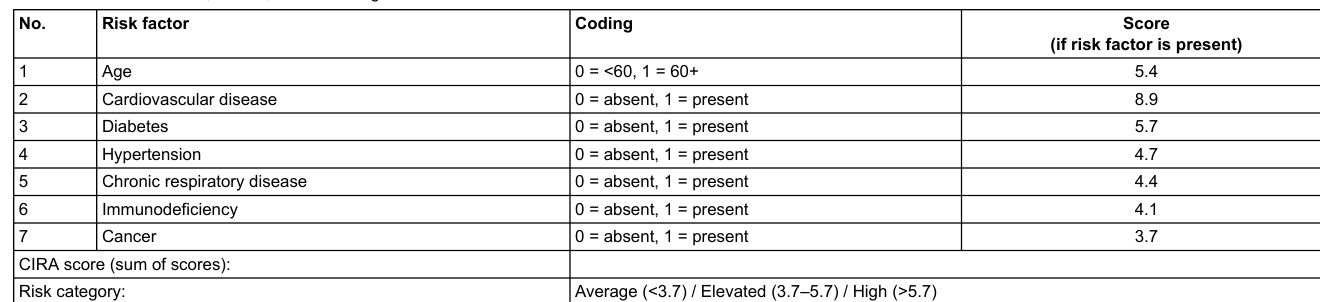
Table 2: CIRA risk factors, scores, and risk categories